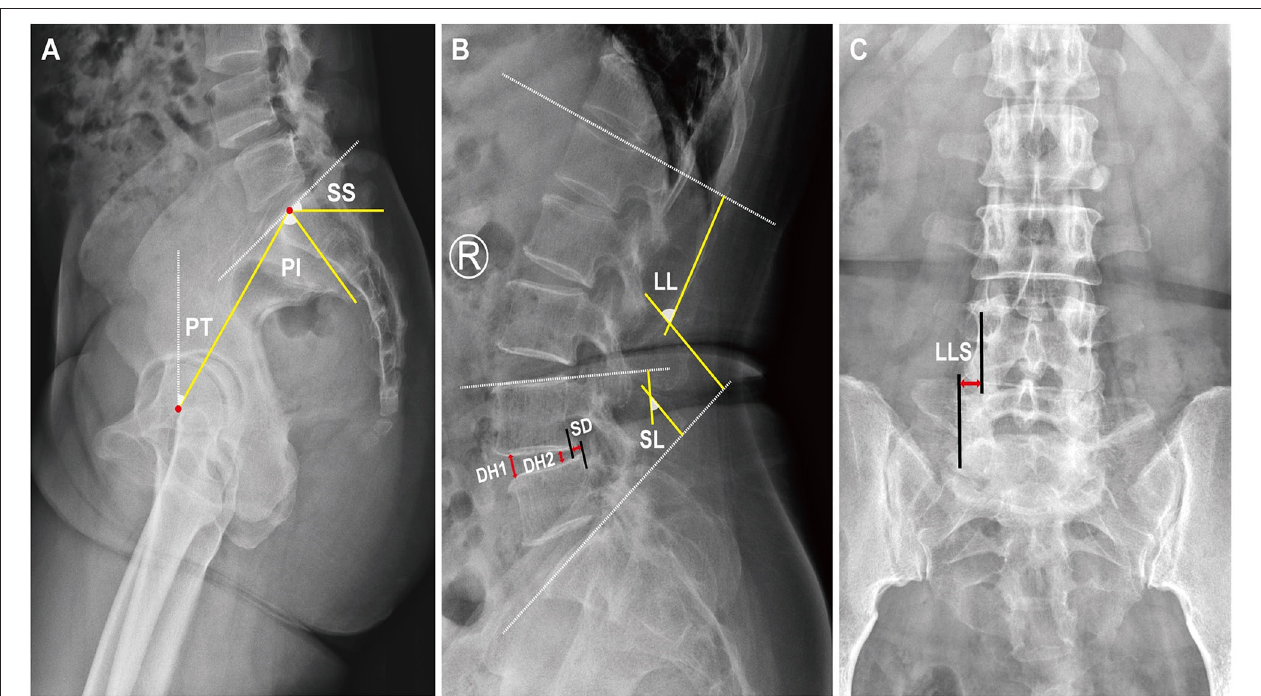
FIGURE 1 | A schematic diagram of spinopelvic parameters, lumbar parameters, and lateral listhesis (LLS). Spinopelvic parameters (A) included pelvic incidence (PI), pelvic tilt (PT), and sacral slope (SS). Lumbar parameters (B) included lumbar lordosis (LL), segment lordosis (SL), slip degree (SD), and disc height (DH). Lateral listhesis (LLS) was measured according to (C) .